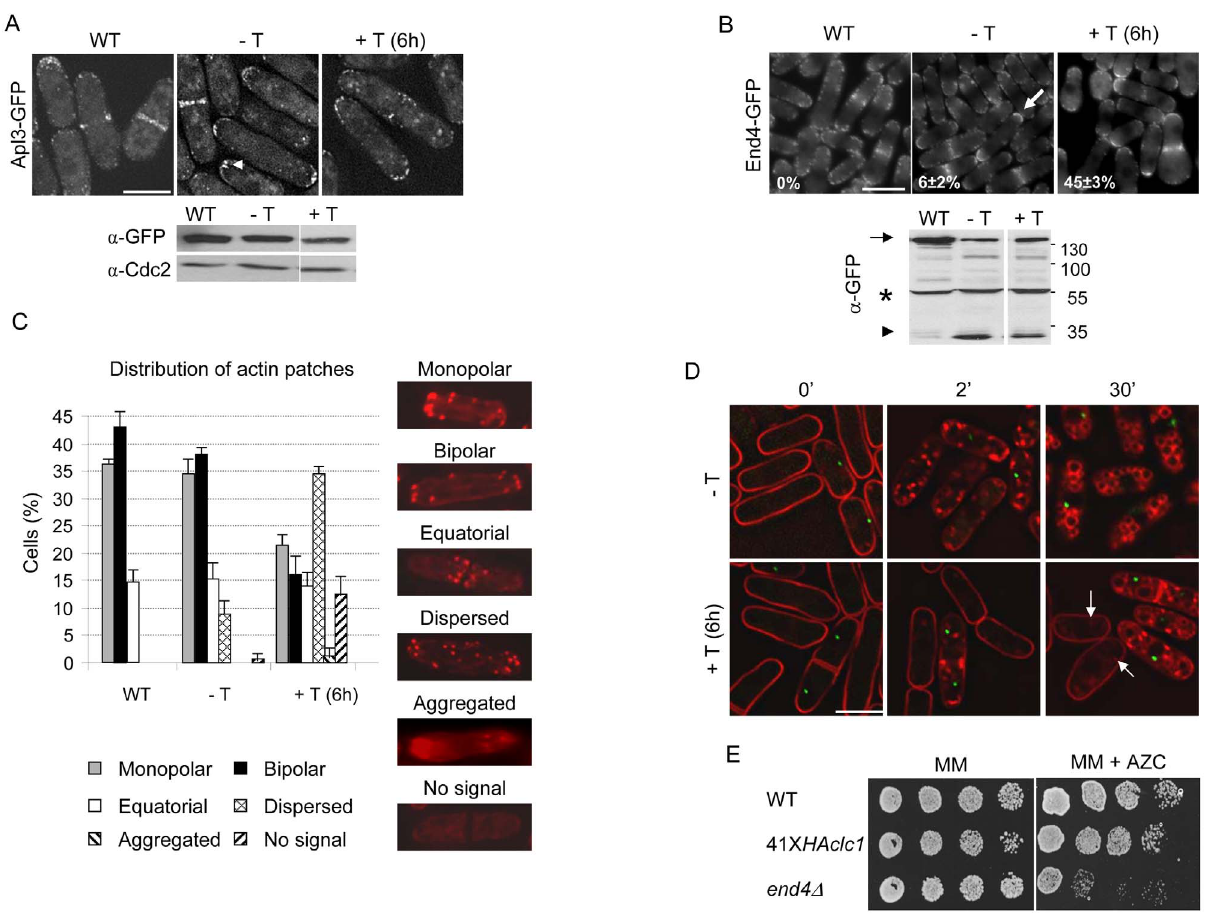
Figure 7. Analysis of endocytosis in 41X HAclc1 cells. A. Upper panels, Apl3-GFP distribution in the wild-type (WT) and 41X HAclc1 strains grown in the absence ( 2 T) and the presence of thiamine ( + T) for 6 hours; the arrowhead denotes clustered Apl3-GFP dots. Lower panel, Anti-GFP and anti- Cdc2 Western blot from the same samples. B. Same as in A but the cells bear End4/Sla2-GFP. The arrow denotes a cell that exhibits a continuous fluorescence at the cell surface. The number of cells with such a distribution of End4-GFP is indicated for each sample. Lower panel, Western blot analysis of cell extracts from the same samples. The arrow denotes End4-GFP, the arrowhead denotes a band that could correspond to the GFP, and the asterisk marks an unspecific band. C. Quantification of the number of cells with different actin patch distribution with respect to the total cell number. Right panels, pictures showing the patterns of actin patch distribution that were scored; cells were stained with Rhodamine-Phalloidin. The experiment was performed three times; a minimum of 500 cells were scored in each experiment. D. FM4-64 uptake in mixed cultures of wild-type cells bearing the spindle-pole-body Sad1 protein fused to the GFP and 41X HAclc1 cells grown in the absence and the presence of thiamine for six hours. Cells were stained with the dye and photographed after the indicated times (in minutes) of incubation at 32 u C; arrows denote internalized FM4-64. The fluorescence images were obtained with a DeltaVision deconvolution microscope; in A, B, and C the images are projections of z-stacks, and in D are medial sections. The bar represents 10 m m. E. 3 6 10 4 cells and serial 1:4 dilutions from the indicated strains were spotted onto MM plates and MM plates supplemented with 0.9 m M of the L-proline analogue L-azetidine-2-carboxylic acid (AZC) and incubated at 28 u C for five days before being